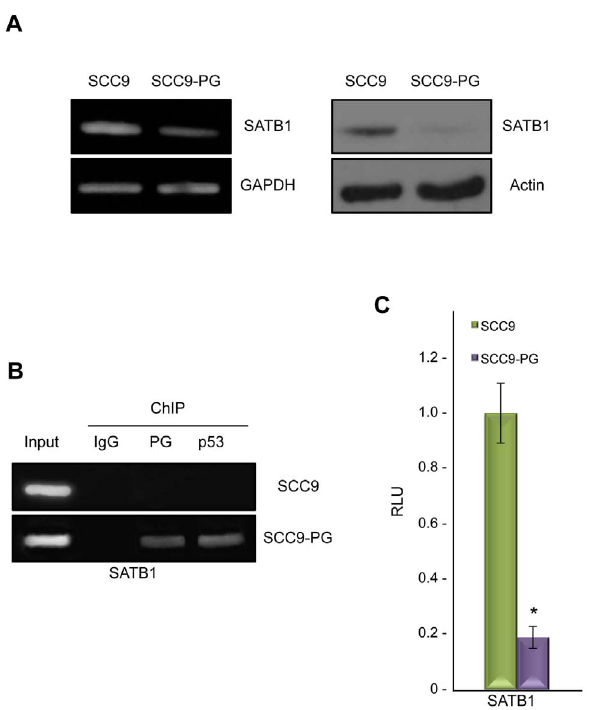
Figure 1. Plakoglobin associates with and suppresses the SATB1 promoter in SCC9-PG cells. A. (Left) Total cellular RNA was isolated from SCC9 and SCC9-PG cells, reverse transcribed and processed for PCR using primers specific to SATB1 and GAPDH. (Right) Equal amounts of total cellular proteins from SCC9 and SCC9-PG cells were resolved by SDS-PAGE and processed for immunoblotting with antibodies to SATB1 and Actin. B. SCC9 and SCC9-PG cells were formaldehyde fixed and processed for chromatin immunoprecipitation. Following sonication, extracts were immunoprecipitated using control IgG, plakoglobin and p53 antibodies. Following extensive washes, immunoprecipitated DNA was separated from the immune complexes and purified using standard DNA purification protocols. The purified DNA was then processed for PCR using SATB1 primers. As a positive control, total cellular DNA (Input) was amplified using the same primers. C. SCC9 and SCC9-PG cells were transfected with luciferase reporter constructs under the control of a 1.2 kb sequence of the SATB1 promoter. Luciferase activities were measured 48 hours post-transfec- tion. The levels of luciferase activities from the vector and SATB1 reporter constructs were determined from a minimum of three independent transfections and normalized for transfection efficiency by co-transfection with a b -galactosidase expression vector. The SATB1 promoter activity was normalized to the corresponding vector activity for each cell line and then normalized to SCC9 (*p , 0.01). PG, plakoglobin; RLU, Relative Light